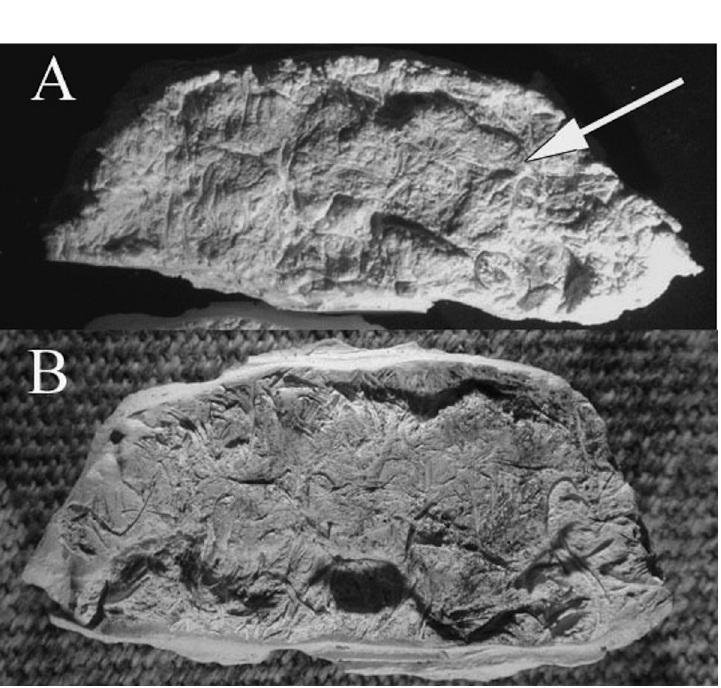
Fig 9. Evidence of dental wear. The arrow in 9a points to a molar cast that has three ridges around the margins of the occlusal surface. It is very likely that this represent dental wear of the softer dentin in the center of the tooth with a raised ridge of harder enamel around the margins of the surface. Fig 9b shows flat wear of molars from one quid. Cusps are not visible.